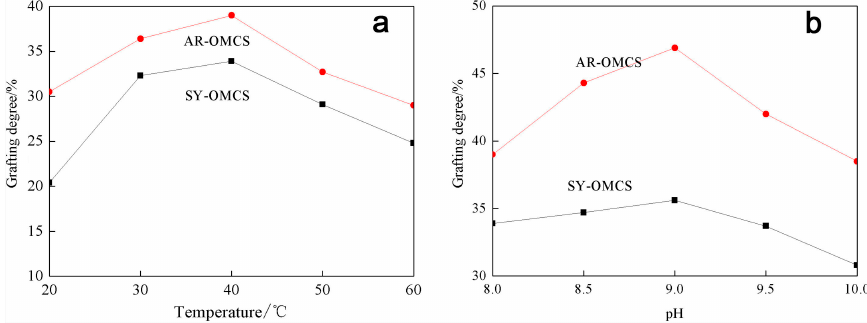
Figure 3. Effect of the amidation reaction conditions on the grafting degree of SY and AR onto OMCS.